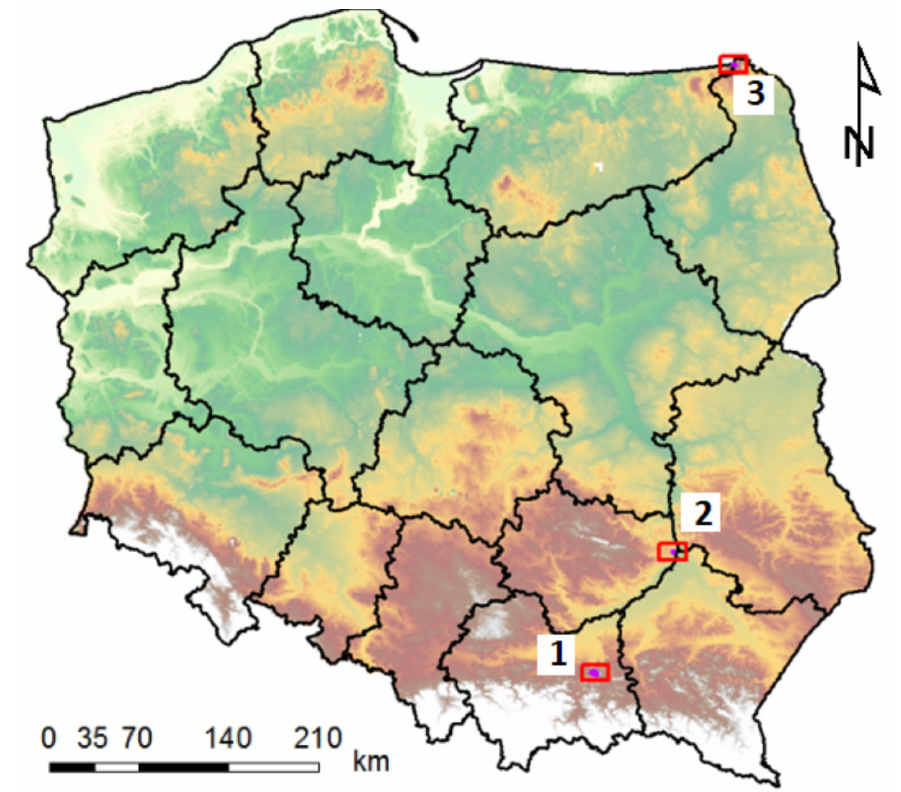
Figure 1. The research areas localisation: 1—Janowice, 2—Winiarki and 3—Bolcie (hypsometric map from WMS: http://mapy.geoportal.gov.pl; (accessed on 21 December 2020); Ref. Syst: EPSG 2180). The research area of Janowice covers an area of 1355 ha and is located in the Western part of Pog ó rze Ci˛e˙zkowickie. The terrain heights (based on ALS data) range from 199 m above sea level up to 454 m above sea level. The maximum slopes of the terrain are significant and reach values up to 78 ◦ (ALS data) (Figure 2a).The land is mainly covered by grasslands and agricultural crops (55.9%), forests and wooded areas (29.3%), built-up areas (5.8%) and permanent crops (4.5%) (based on the BDOT10k topo reference database). The research area of Winiarki covers an area of 277 ha and is located in the eastern part of the Sandomierz Upland. Terrain heights (ALS data) range from 138 m above sea level up to 208 m above sea level, and the slope values (ALS data) in this area reach 74 ◦ (Figure 3a). The land is mainly covered by permanent crops (38.1%), grasslands and agricultural crops (32.5%), forests and wooded areas (23.3%) and built-up areas (5.5%) (based on the BDOT10k topo reference